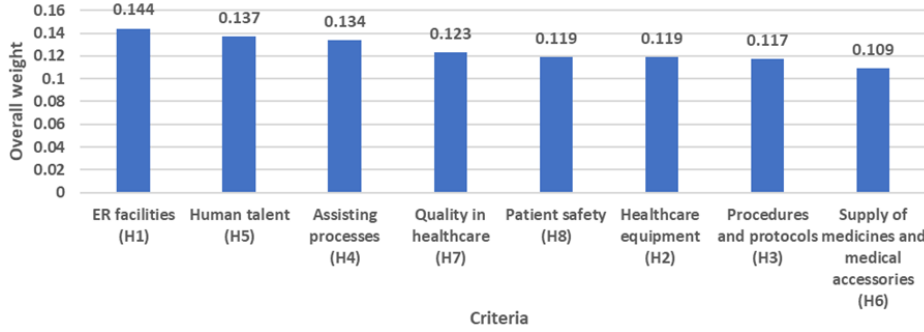
Figure 4. Ranking of criteria in the ED performance evaluation model.